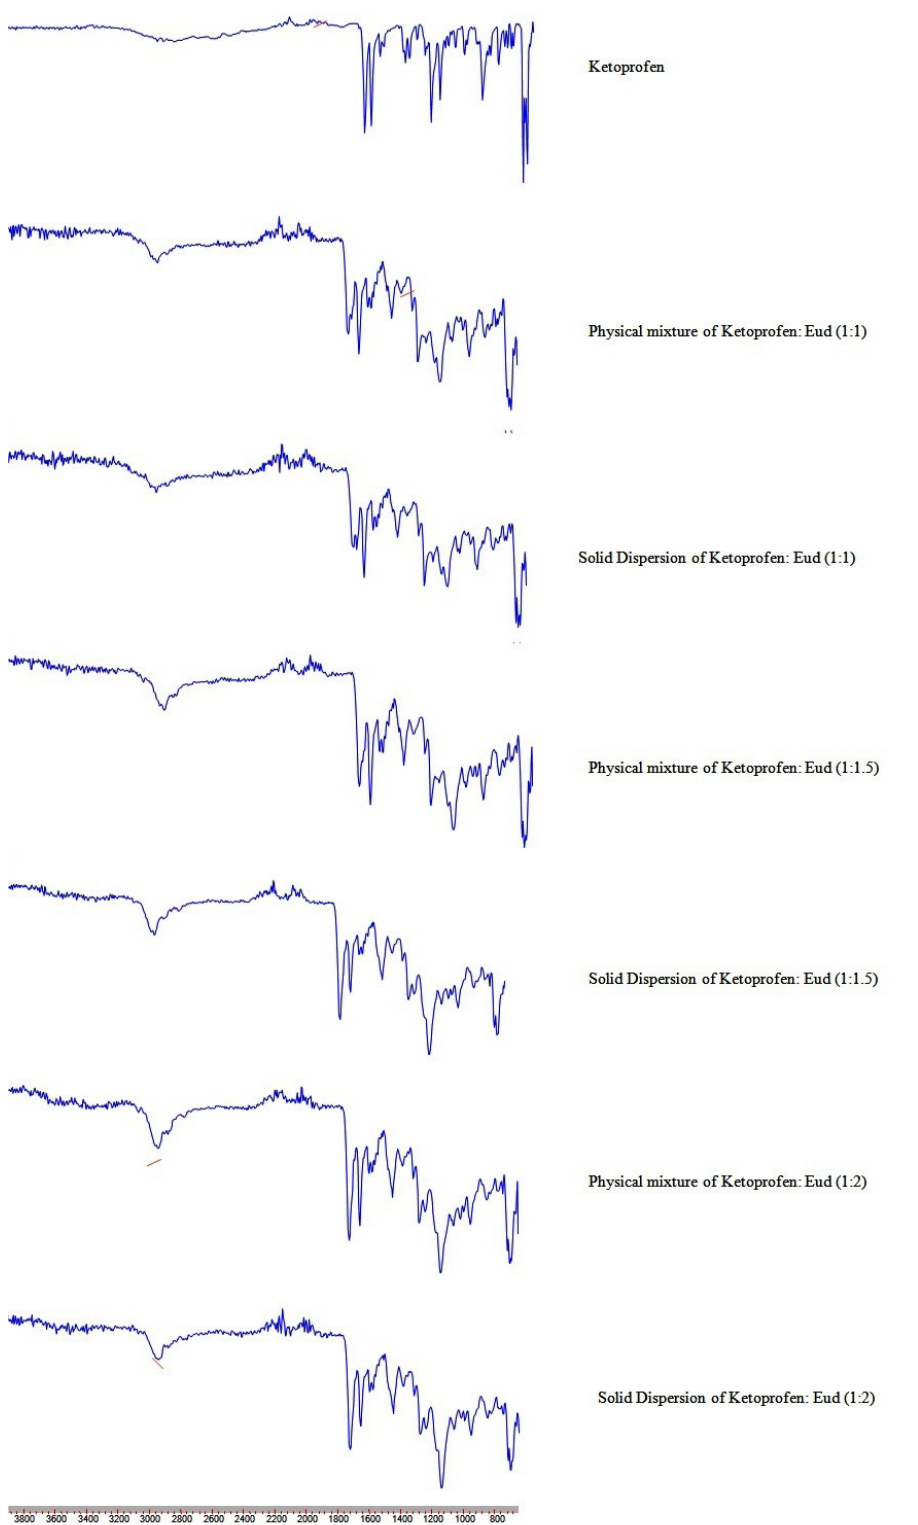
FIGURE 6 - ATR-FTIR of Ketoprofen, physical mixtures and solid dispersions with Eudragit S